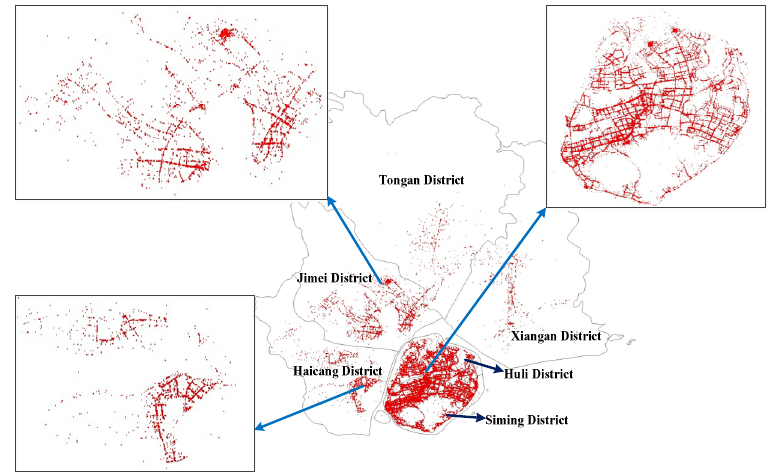
Figure 1. Example of experimental data.